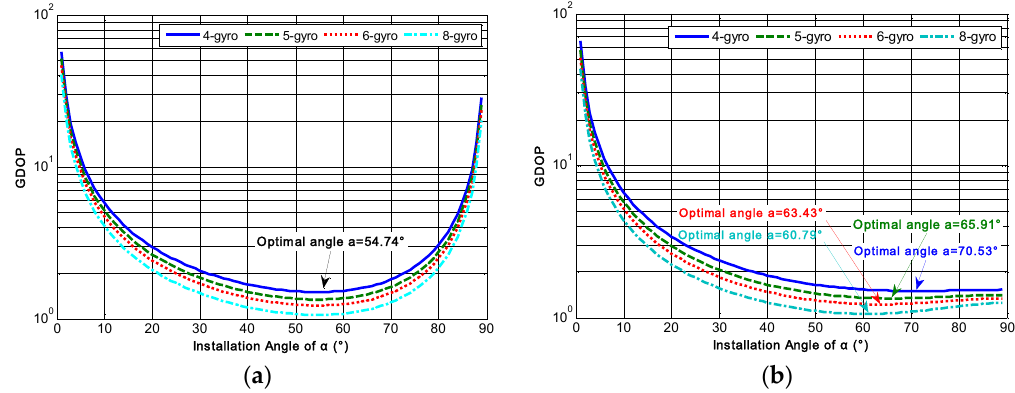
Figure 8. The relationship between GDOP and angle α for different structures ( ρ = 0). ( a ) Configuration scheme 1; ( b ) configuration scheme 2.